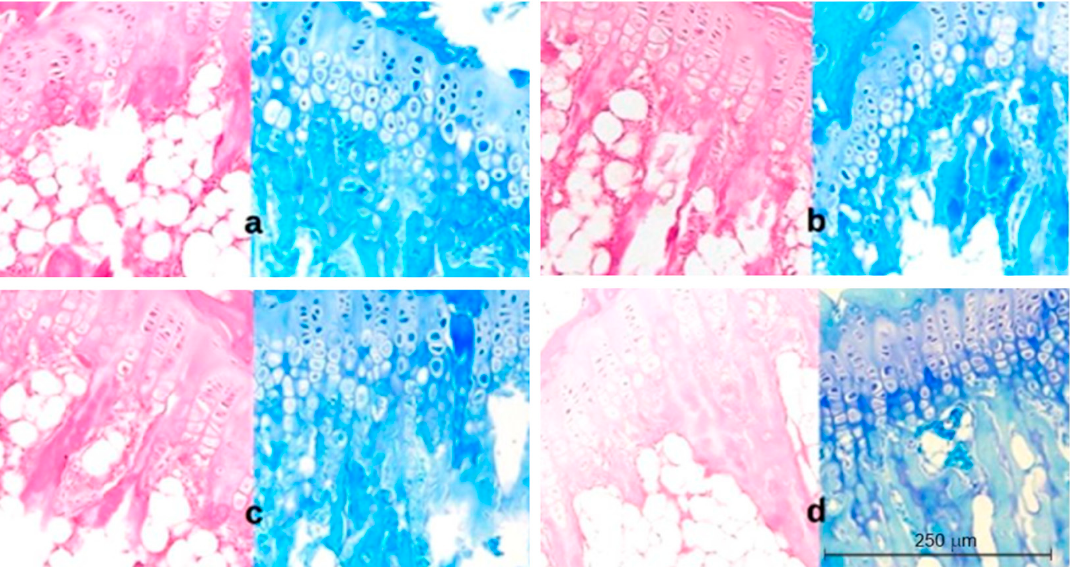
Figure 5. Group III. Histopathological image of cartilage from the concave side ( a ): regained regular arrangement of the proliferative and hypertrophic layers, reactivation of the hypertrophic layer; central side ( b ): regular arrangement of the columns of cells, wide hypertrophic layer; convex side ( c ): regular arrangement of the columns of cells, wide hypertrophic layer; control group ( d ): regular arrangement of the columns of cells, active hypertrophic layer. Ninety-four-day-old animals (end of the experiment after regeneration); H&E and Methyl Blue staining 200 ×